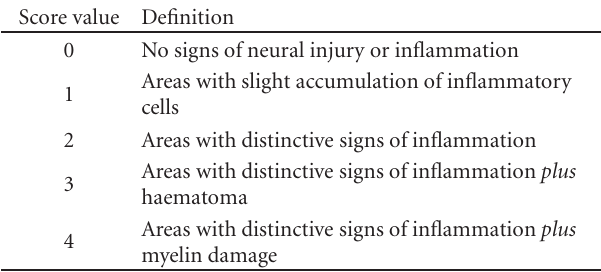
Table 1: Nerve injury score. Slight nerve damage is represented by the score grades 1 and 2. A severe nerve injury with structural damage is described with score grades 3 and 4. For detailed description with histologicalexamples, please refer to Steinfeldt and coworkers